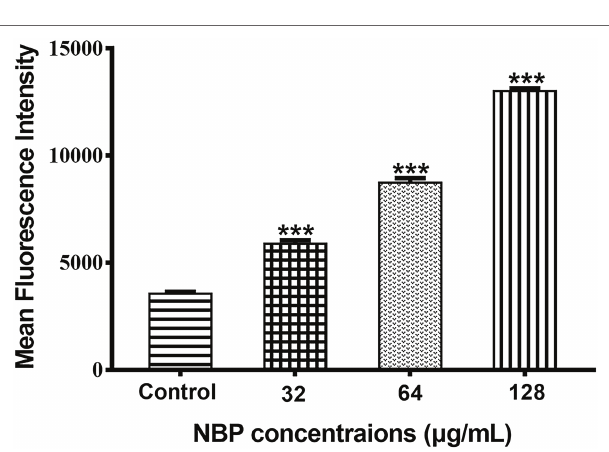
FIGURE 6 | Effect of NBP on the levels of ROS in C. albicans . Yeast cells pretreated with diverse concentrations of NBP (0, 32, 64, and 128 μg/ml) for 4 h were incubated with 40 μM DCFH-DA and then analyzed by a flow cytometer. Values represent the means ± standard deviation of three replicates.*** p < 0.001 compared with the control group (one-way